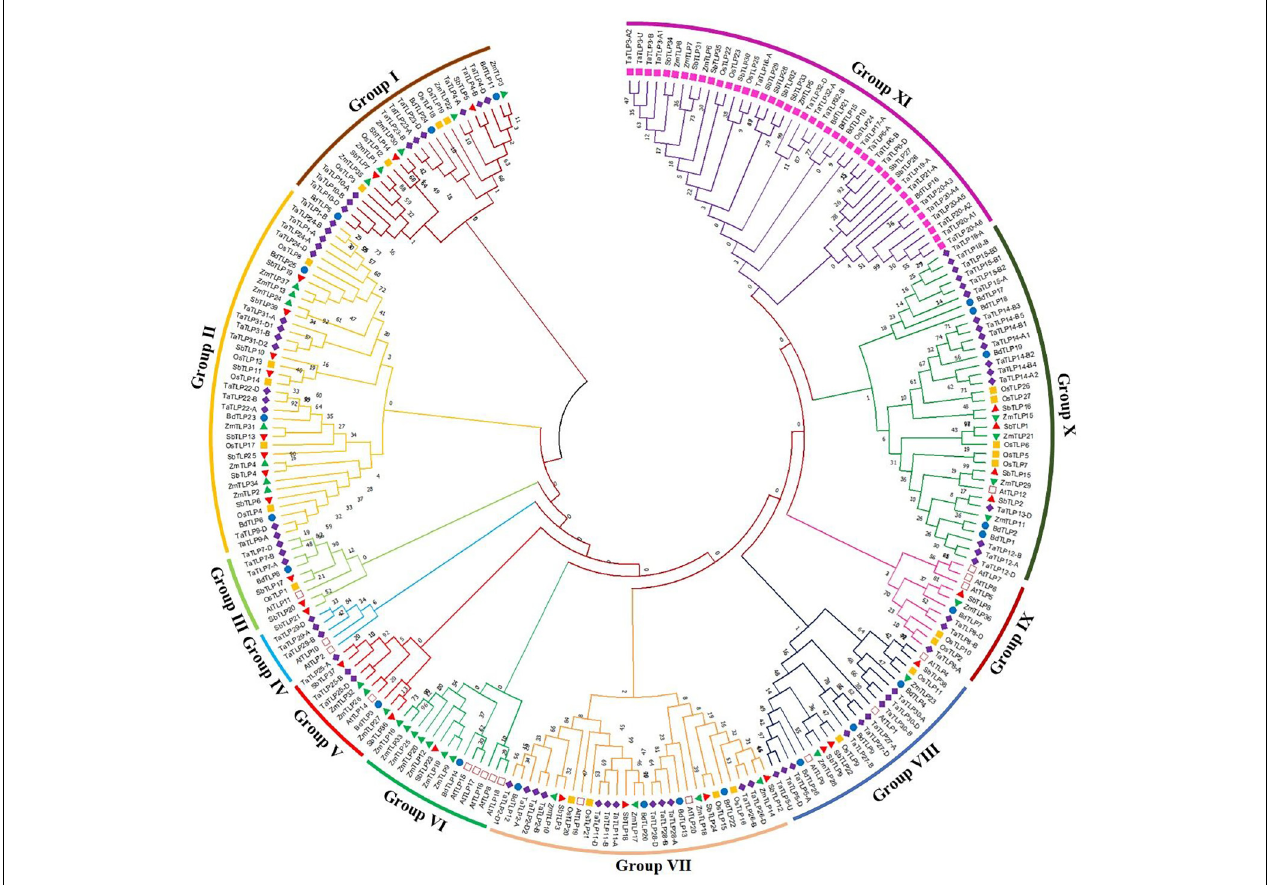
FIGURE 3 | Phylogenetic tree analysis of A. thaliana, B. distachyon, O. sativa. S, bicolor, T. aestivum, and Z. mays using full-length peptide of TLPs. The figure shows the phylogenetic tree of TLPs, built by the maximum likelihood approach with 1000 bootstrap values using MEGA X software. The phylogenetic tree displays the clustering of TLPs of six plant species in I-XI different groups, each group is colored differently. The TLPs from each plant are marked with a different